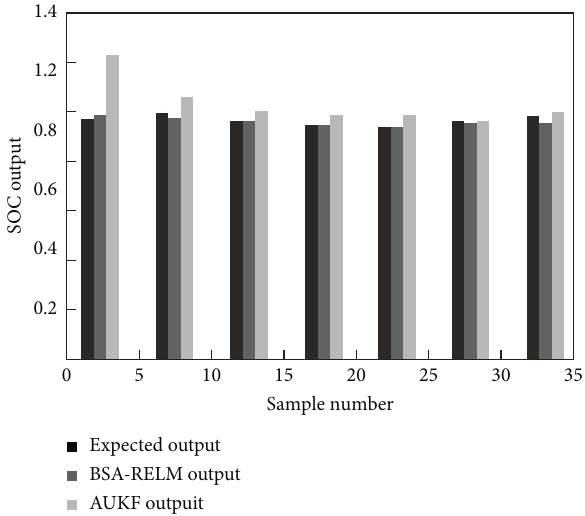
Figure 14: Output results of the Kalman signal big data algorithm and the AUKF algorithm.